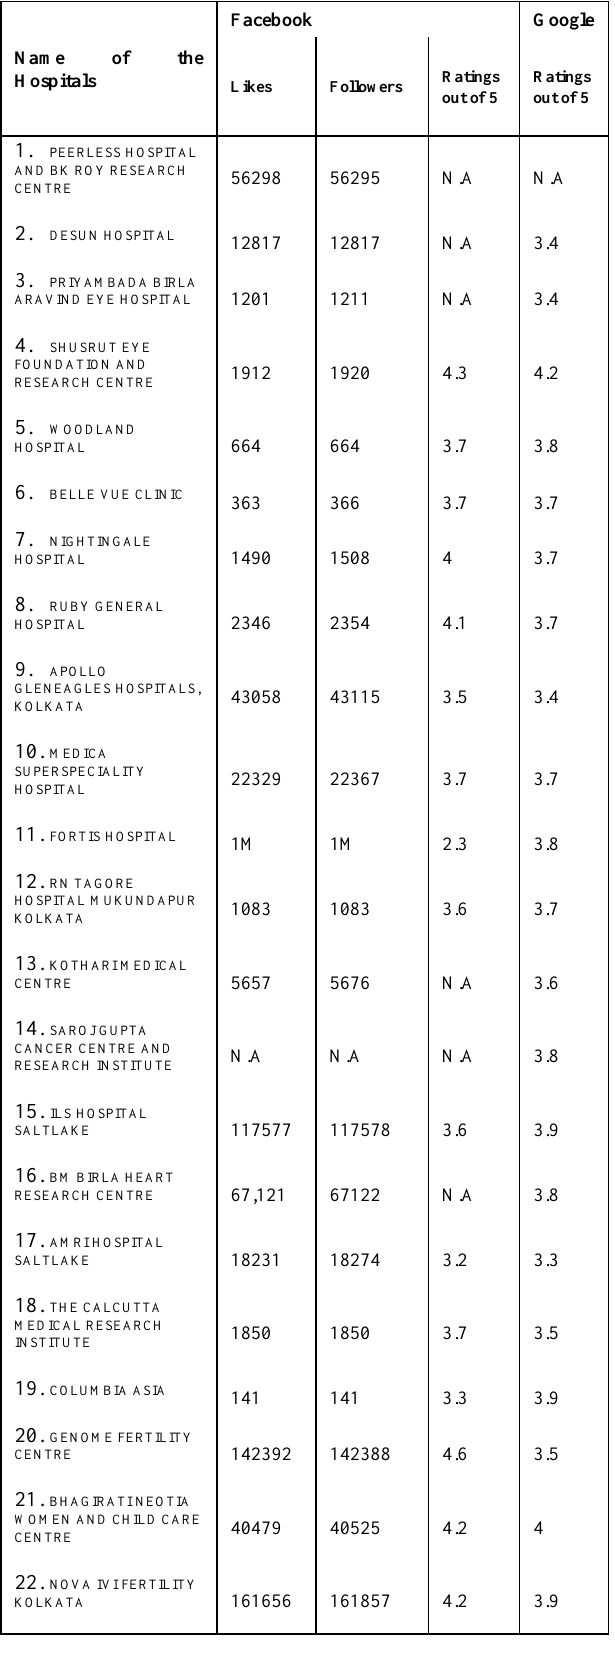
Table 2. Online profile of sample hospitals (accessed on or